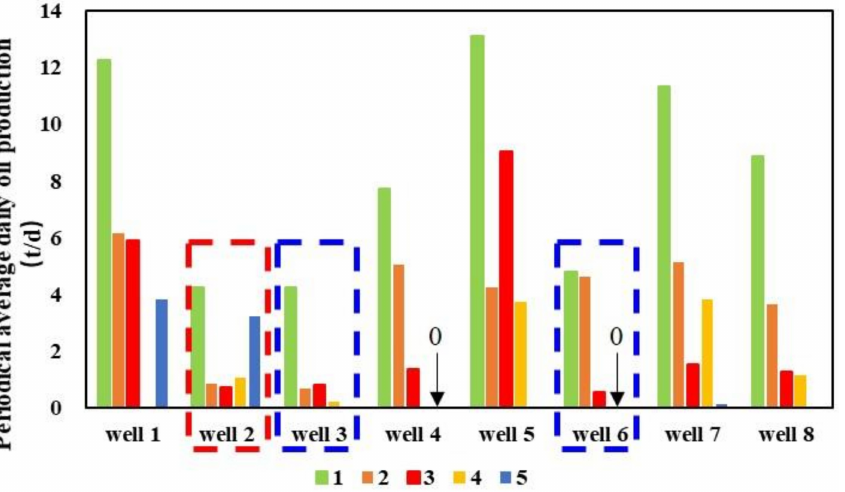
Figure 6. Periodical average water cut of typical wells in block M.